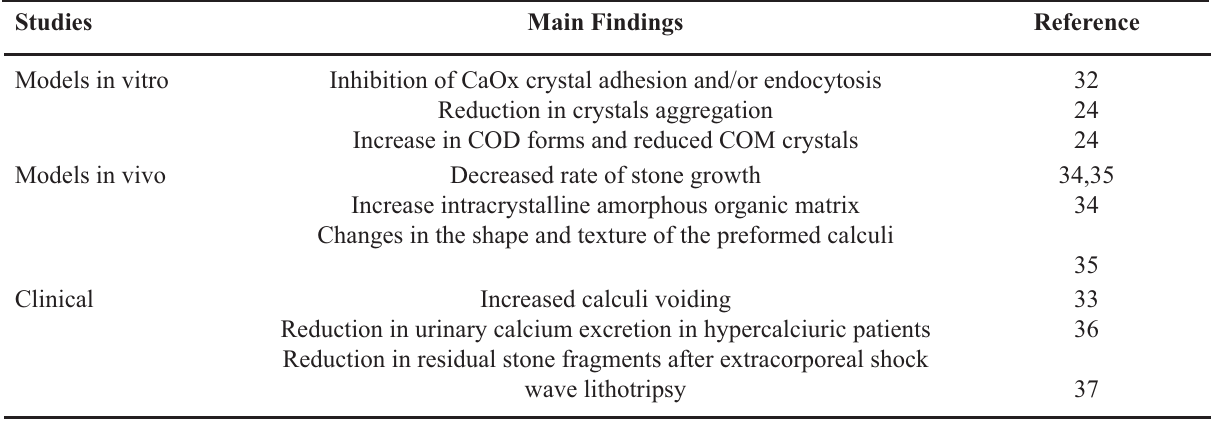
Table 1 – Summary of main